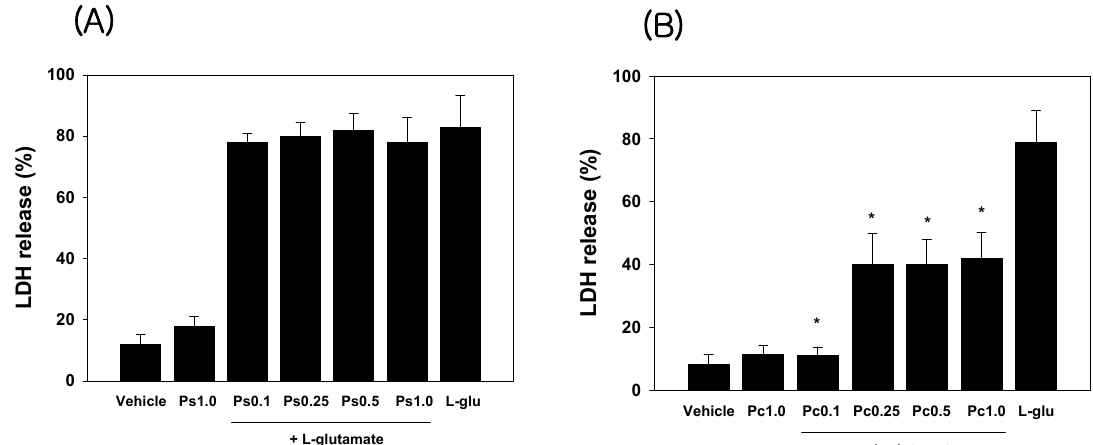
Figure 2. Protection of glutamate-induced neurotoxicity in cultured cortical neurons with phytoceramide. Sphingolipids were co-treated with glutamate (60 µM) in cultured neuronal cells for 24 h at 37 °C. Lactate dehydrogenase (LDH) was measured at 340 nm using a microplate spectrophotometer. Data represent the mean ± standard error (SE). * p < 0.05 in comparison with L -glu treated group. Ps: phytosphingosine; Pc: phytoceramide; TP: